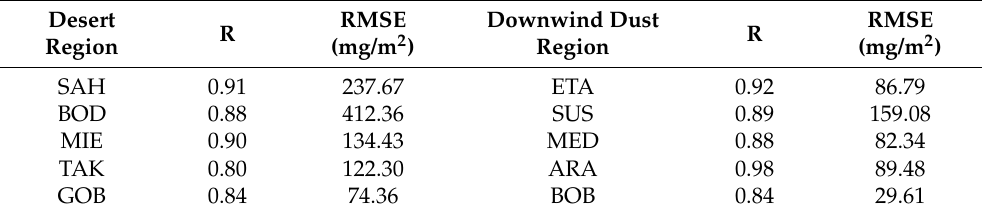
Table 2. The statistics for the comparisons of monthly dust column concentration between MERRA-2 data and POLDER/GRASP component products over the regions of interest. R indicates the correla- tion coefficient, and RMSE indicates root mean square